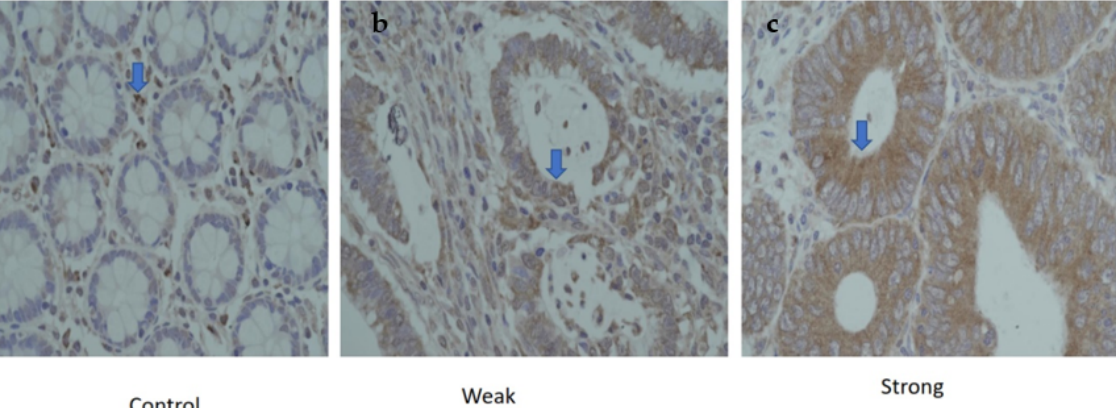
Figure 3. Immunohistochemistry staining for CTLA-4. (Arrows). A group of colonic adenocarcinomas showing strong positive epithelial neoplastic luminal for CTLA-4 in an early-stage patient ( a ) Control. ( b ) Weak expression. ( c ) Strong expression.